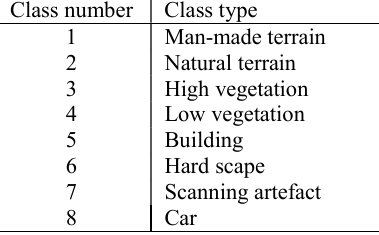
Table 1. Classes in the Semantic3D dataset